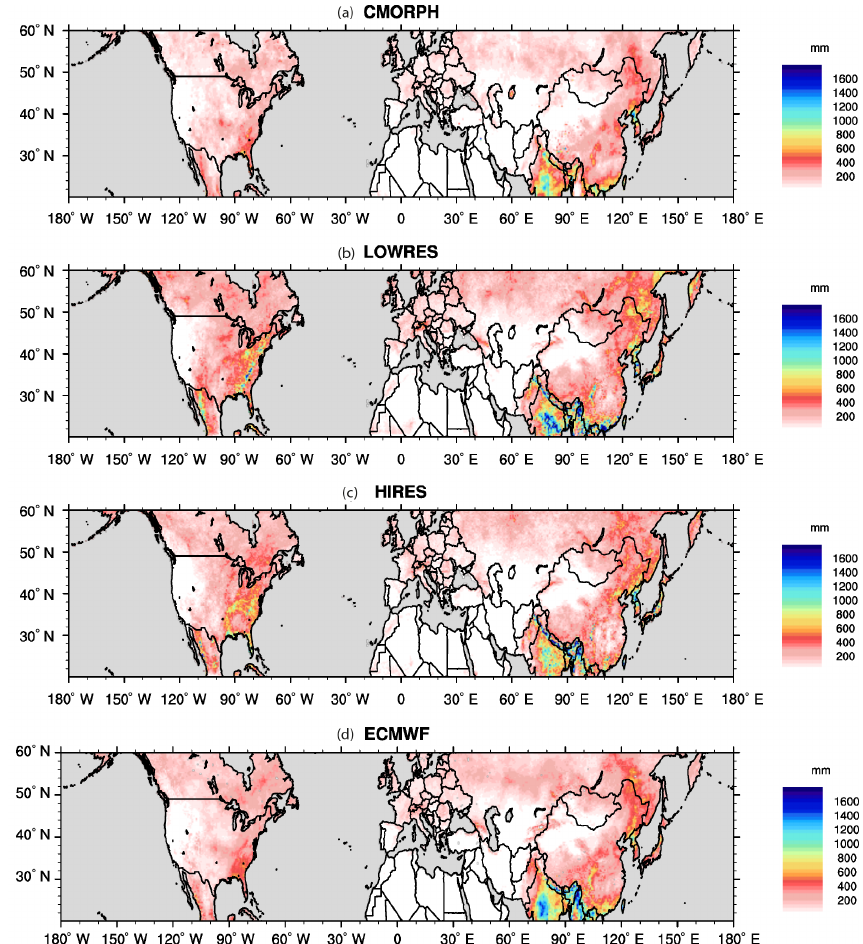
Figure 15. The 2-month accumulated precipitation. Panel (a) shows the CMORPH analysis, (b) shows the LOWRES simulation, and (c) dis- plays the HIRES simulation. Panel (d) displays the accumulated precipitation from the operational ECMWF 12h forecast starting at 00:00 and 12:00UTC on each